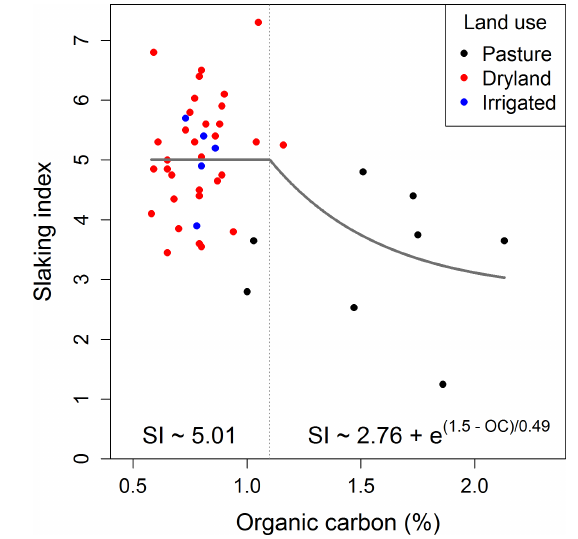
Figure 4. Relationship between slaking index (SI) and organic car- bon (OC) for soil samples with clay content ≥ 25% and CEC:clay ratio > 0 . 5. A segmented, exponential decay function containing a lag phase and threshold value of 1.1% OC was fit to the observed data points. Land use at each observation point is